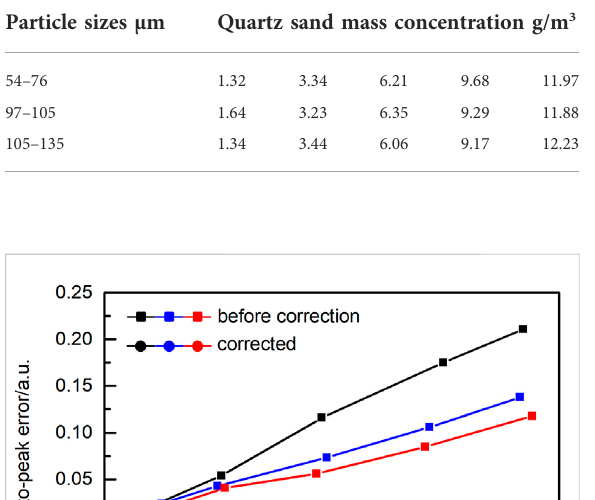
TABLE 1 Mass concentration of three particle sizes of quartz sand.